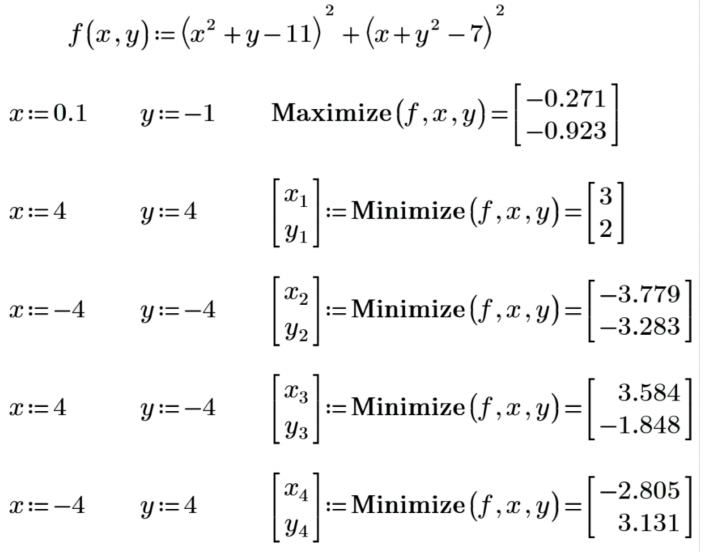
Figure 19. Finding the extrema of the Himmelblau’s function.